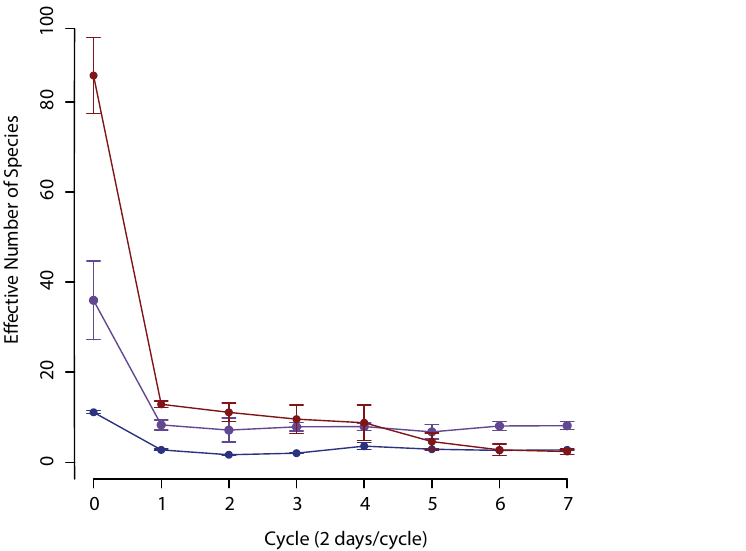
Fig 5. Initial inoculum alpha diversity is not correlated with reactor diversity. The microbialinoculaused vary in diversity. The diversity of the microbialcommunities present in the reactors decreases over the course of the experiment. Diversity is presented as the effective number of speciesover time for Camel (dark blue), Mangrove (purple),and Sludge(red)